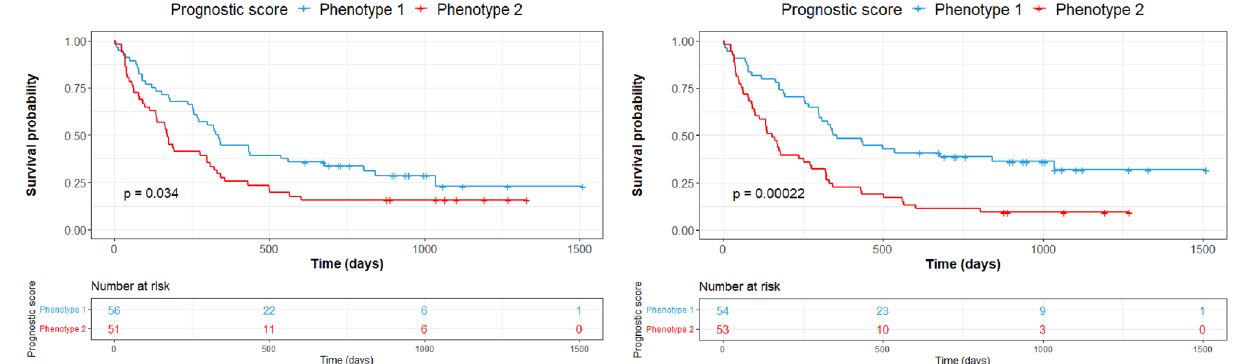
Figure 3. Survival analysis using multivariable models. Progression-free survival for the multivariable model built using only clinical covariates (PDL1 expression, ECOG, BMI and smoking status) (left) and for the multivariable model built using clinical covariates and radiomic phenotypes.